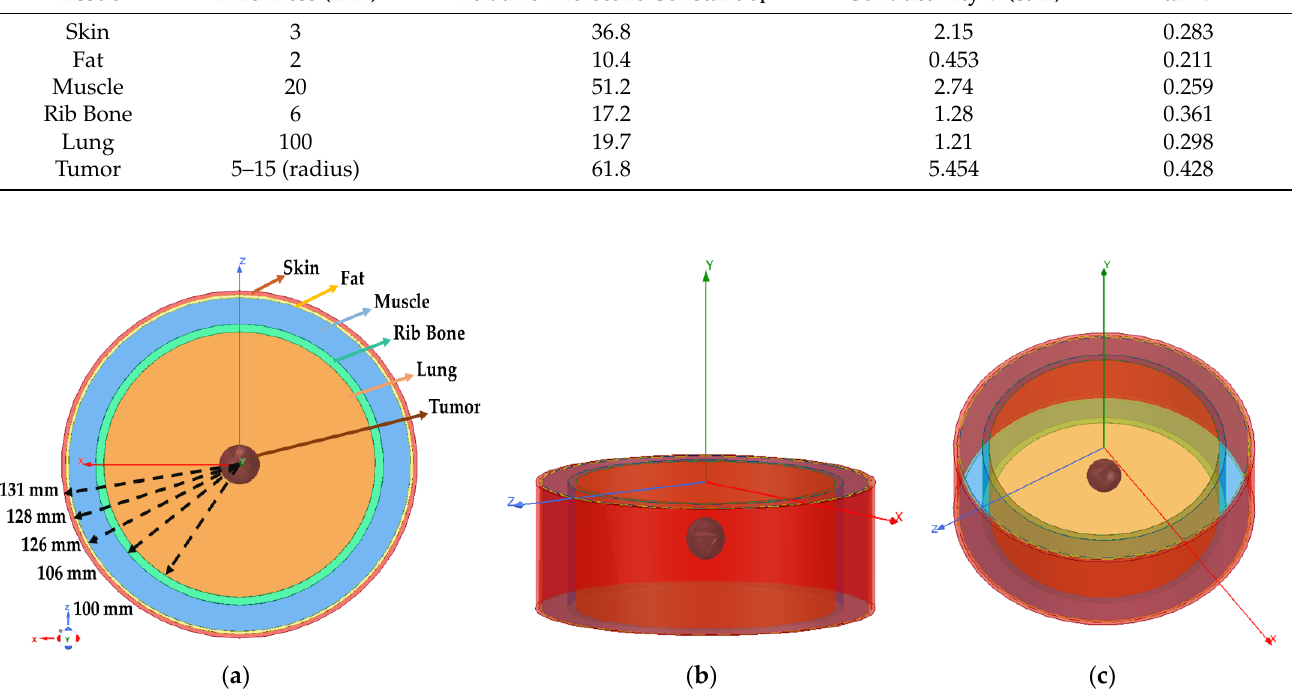
Figure 3. Concentric cylinder geometry of lung phantom model with spherical tumor inclusion: ( a ) Top view; ( b ) Trimetric view; ( c ) Dimetric view.